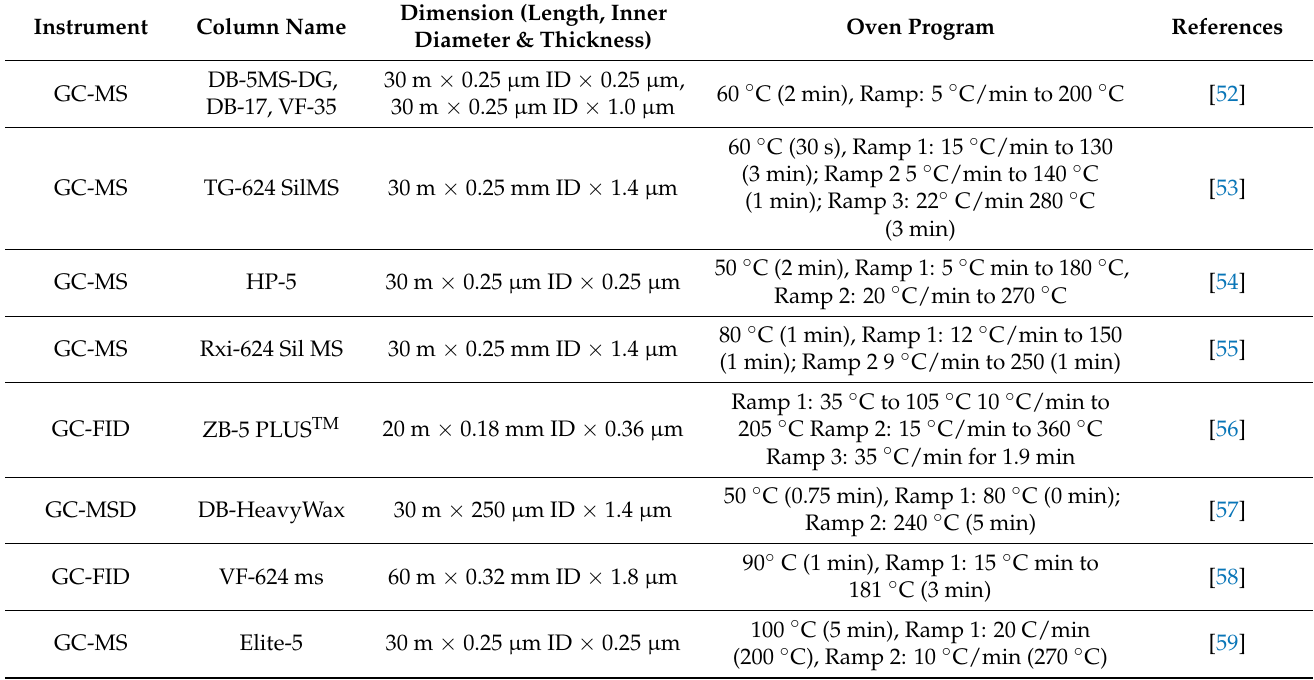
Table 1. List of GC-MS column and oven program for terpenoid